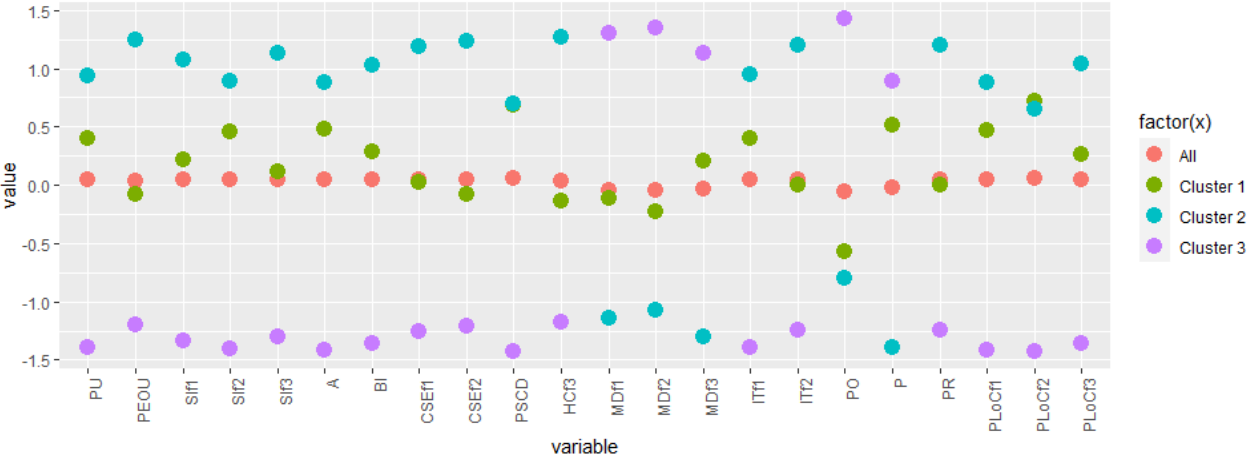
Figure 3. The values for the clusters and the overall population. PU—perceived usefulness; PEOU— perceived ease of use; SI—social influence; A—attitude; BI—behavioural intention; CSE—computer self-efficacy; PSCD—perceived severity of chronic disease; HC—health consciousness; MD—moral disengagement; IT—institutional trust; PO—political orientation; P—privacy; PR—prosocial respon- sibility; PLoC—perceived locus of